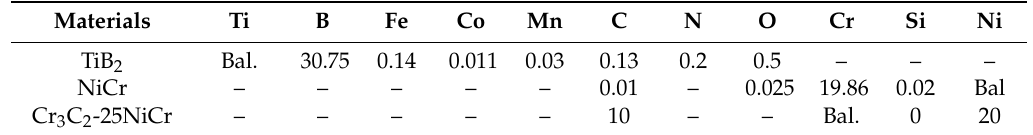
Table 1. Compositions of the powders (wt %).